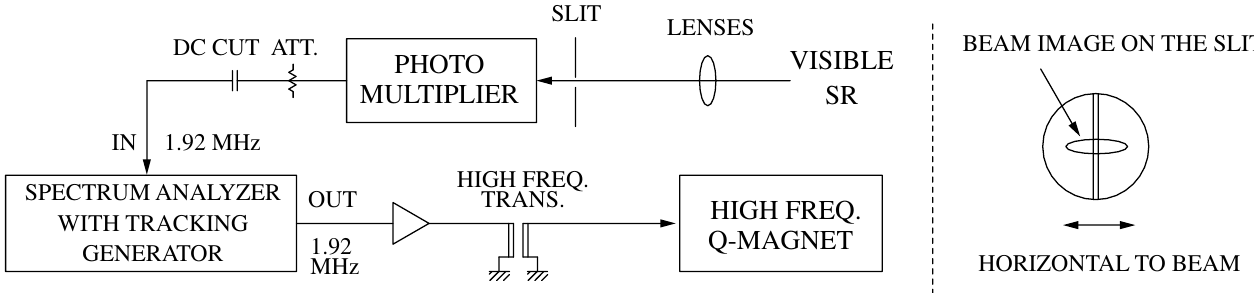
FIG. 1. Setup for measuring the horizontal quadrupolar